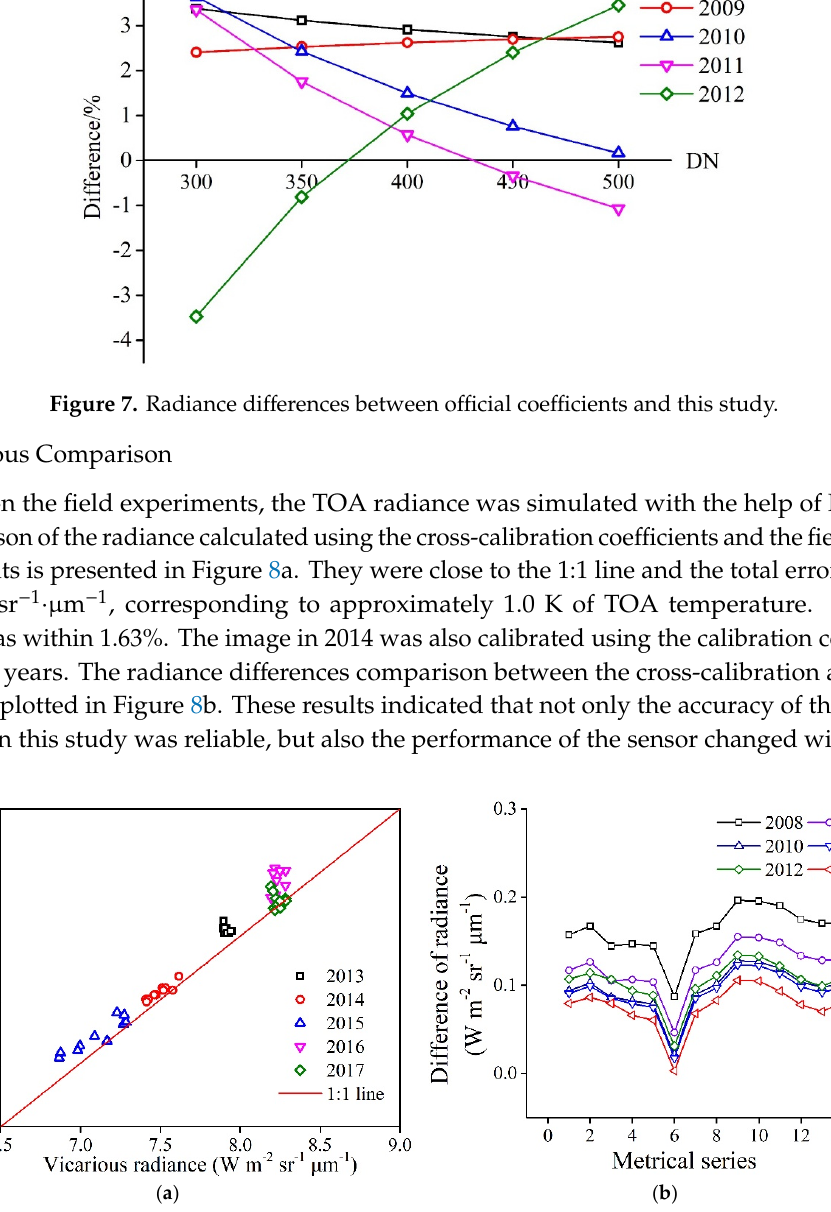
Figure 6. Gains and offsets in different years. ( a ) Numeric values; ( b ) percent changes.